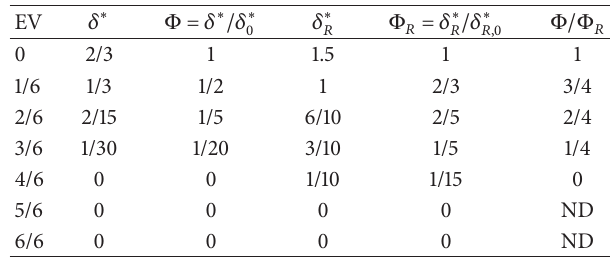
Table 2: Average diffusion coefficients of the model ( 𝛿 ∗ ) and reference model ( 𝛿 ∗ 𝑅 ) shown in Figure 2(b)(b1). EV and ND are as in Table 1.